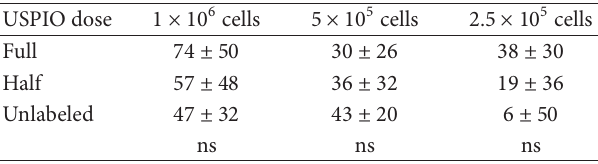
Table 4: MRI intensity differences after 6-hour USPIO incubation.